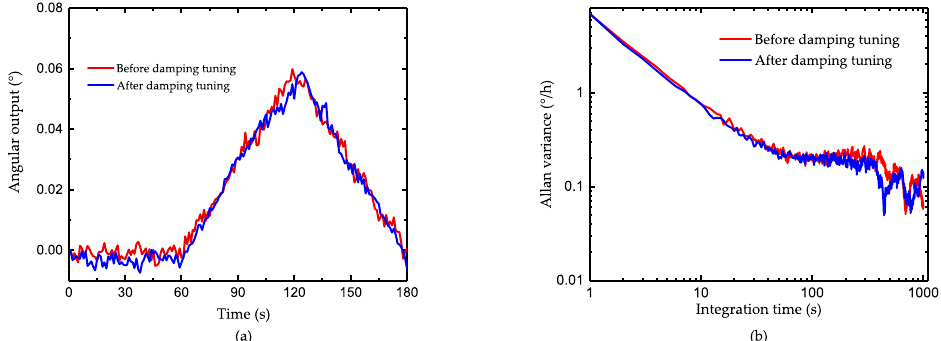
Figure 12. The test of gyroscope performance ( a ) resolution test and ( b ) Allan